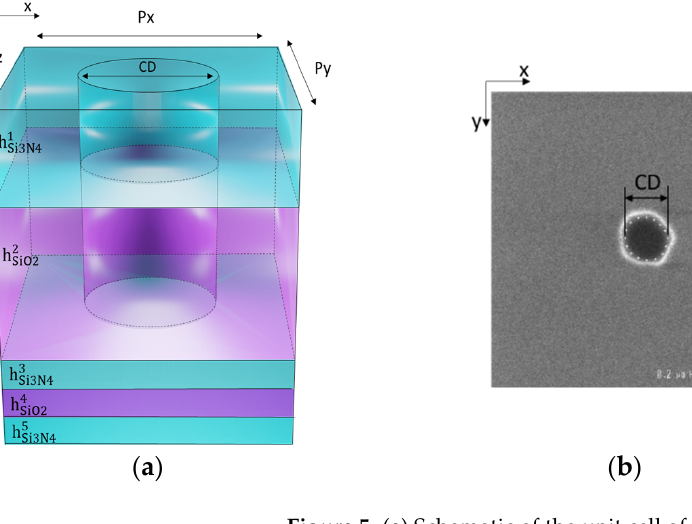
Figure 5. ( a ) Schematic of the unit cell of the Si 3 N 4 /SiO 2 nanohole structure in Case 1. ( b ) Scanning electron microscopy (SEM) cross-section image in the x-y plane of the unit cell of the Si 3 N 4 /SiO 2 nanohole. ( c ) Schematic of the unit cell of the Al nanohole pattern in Case 2. The dimension in the two schematics is not to scale.